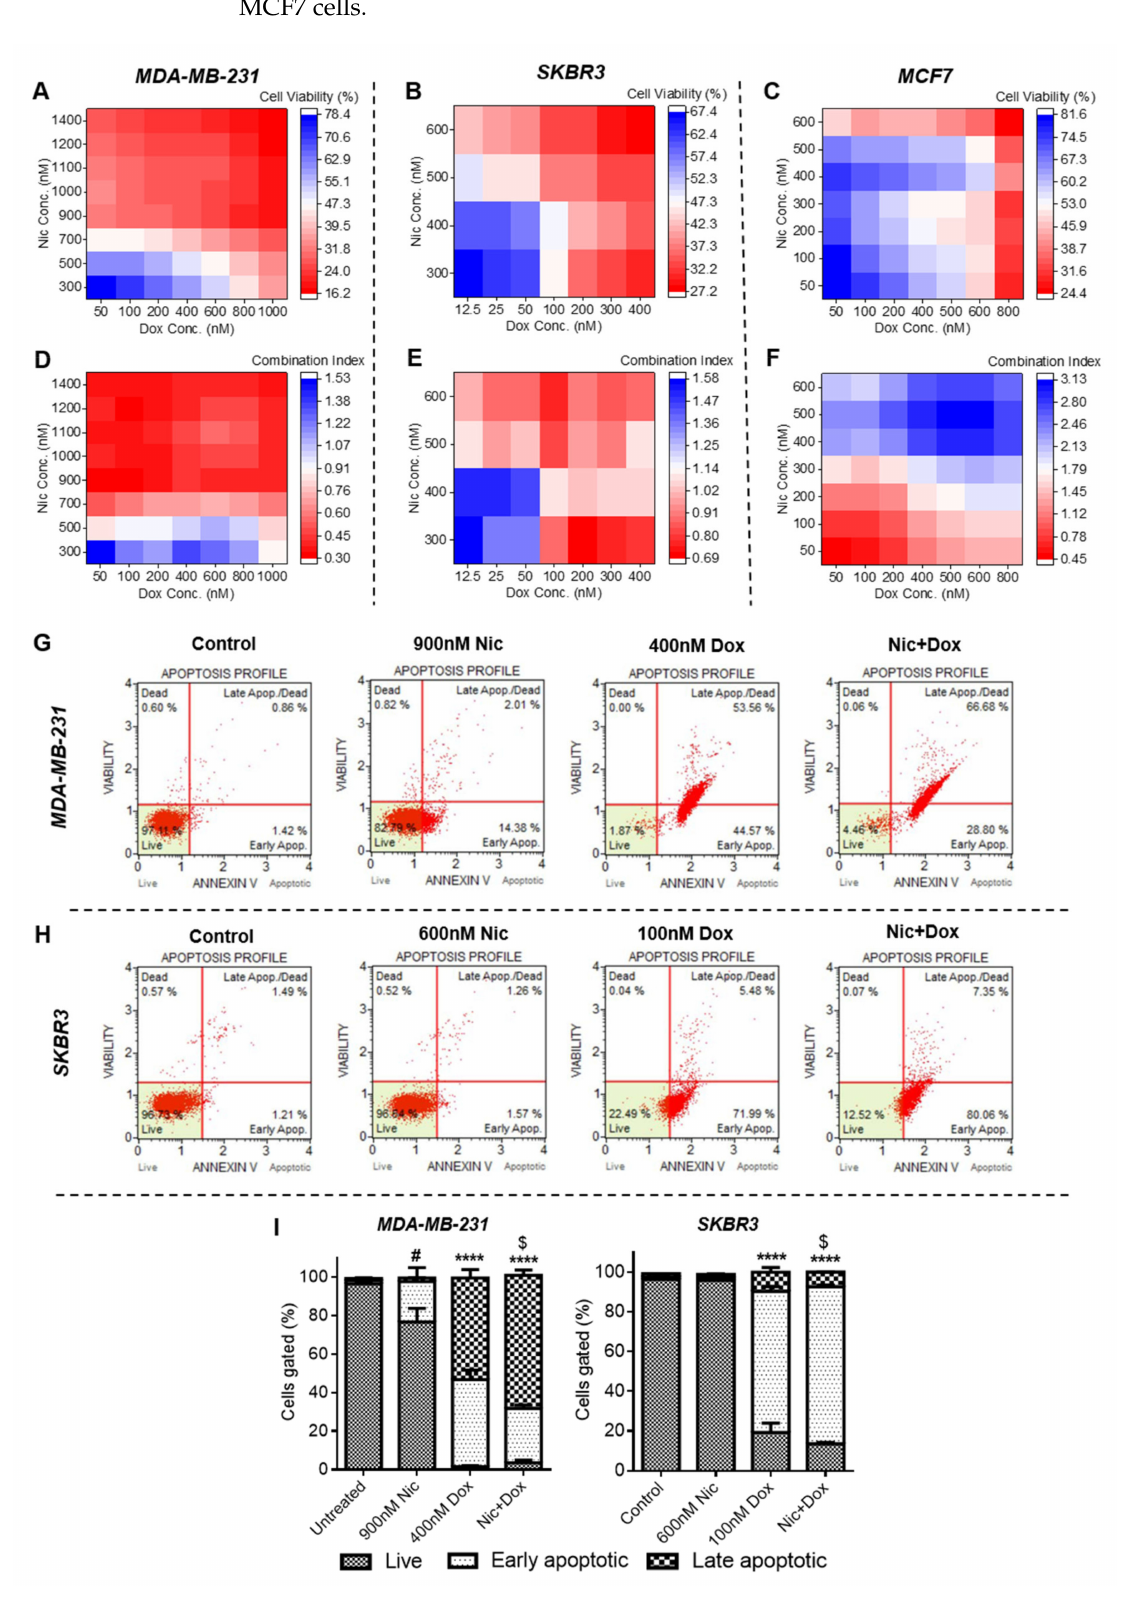
Figure 5. Effect of individual and concurrent treatment of Nic and Dox on breast cancer cells. Cell viability heat maps of concurrent treatment of Nic and Dox for 48 h in ( A ) MDA-MB-231, ( B ) SKBR3, and ( C ) MCF7 cells. Combination index